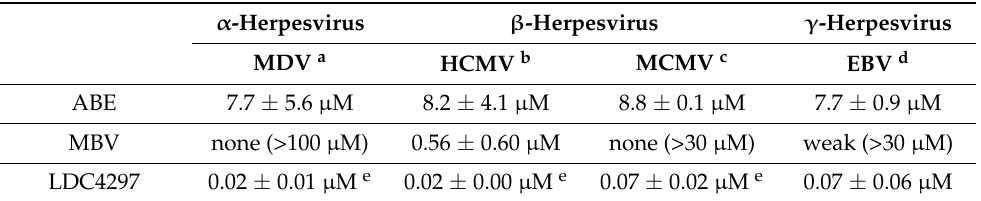
Table 1. EC 50 values determined for three preselected pharmaceutical kinase inhibitors (PKIs) against representatives of α -, β - and γ -herpesviruses.